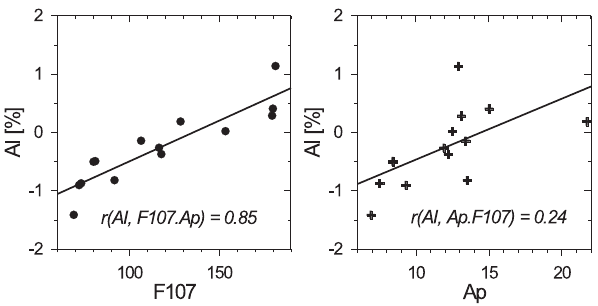
Fig. 7. Dependence of yearly mean AI values on solar activity (left part) and on geomagnetic activity (right part). The included values are the corresponding partial correlation